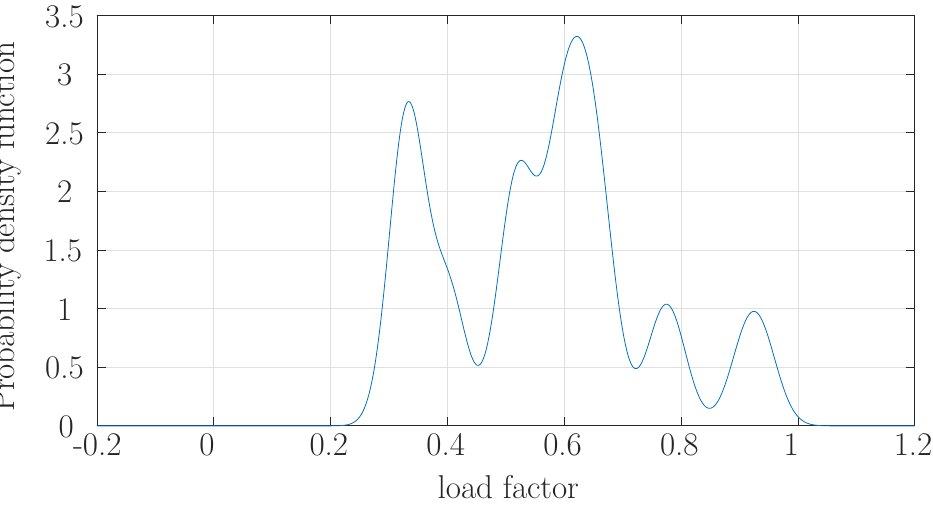
Figure 6. Probability density of consumption rate daily profile.